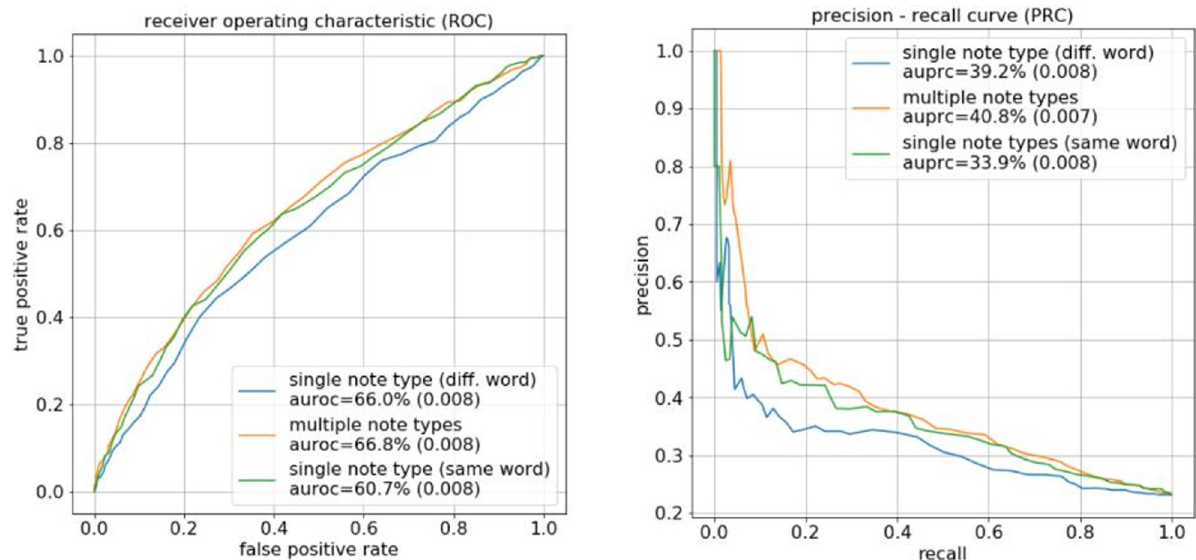
Fig 2. ROC and precision-recall curve for binary PMV prediction. We trained the two single-note topic models and the multi-note topic models on the first 48 hours of the clinical notes for each patient. We then trained a separate logistic regression classifier that took the patient-note topic mixture as input and predicted whether the patient is going to stay on MV for more than 7 days. The trained topic models and logistic classifiers were then applied to the test patients to make the predictions of PMV duration. The prediction accuracy was evaluated by ROC and precision-recall curves. The figure inset shows the AUROC and AUPRC values for each model, and the standard deviations across 10 random splits are in parenthesis.